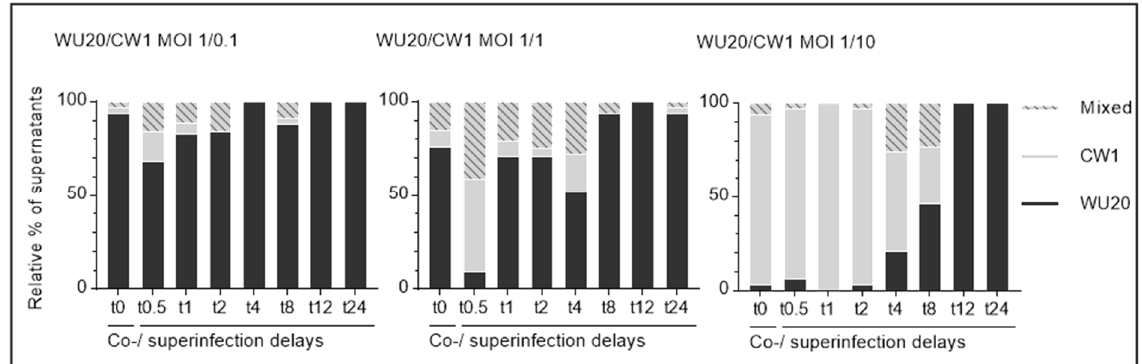
Figure 3. Relative proportions of viable co- or superinfecting murine noroviruses MNV-1 WU20 and CW1 after plaque purification and amplification. Black bars show the proportion of WU20, grey bars show the proportion of CW1, and striped bars indicate mixed signals of both WU20 and CW1 in viral progenies amplified from 36 plaques per condition. One coinfection (t0) and seven asynchronous infections (primary infection: WU20; superinfection at half-hour to 24-h delays (t0.5 to t24): CW1) and varying multiplicities of infection (MOI) were analysed; the MOI of primary infecting WU20 remained stable at 1 throughout all assays while the MOI of superinfecting CW1 varied between 0.1 (left panel), 1 (middle panel), and 10 (right